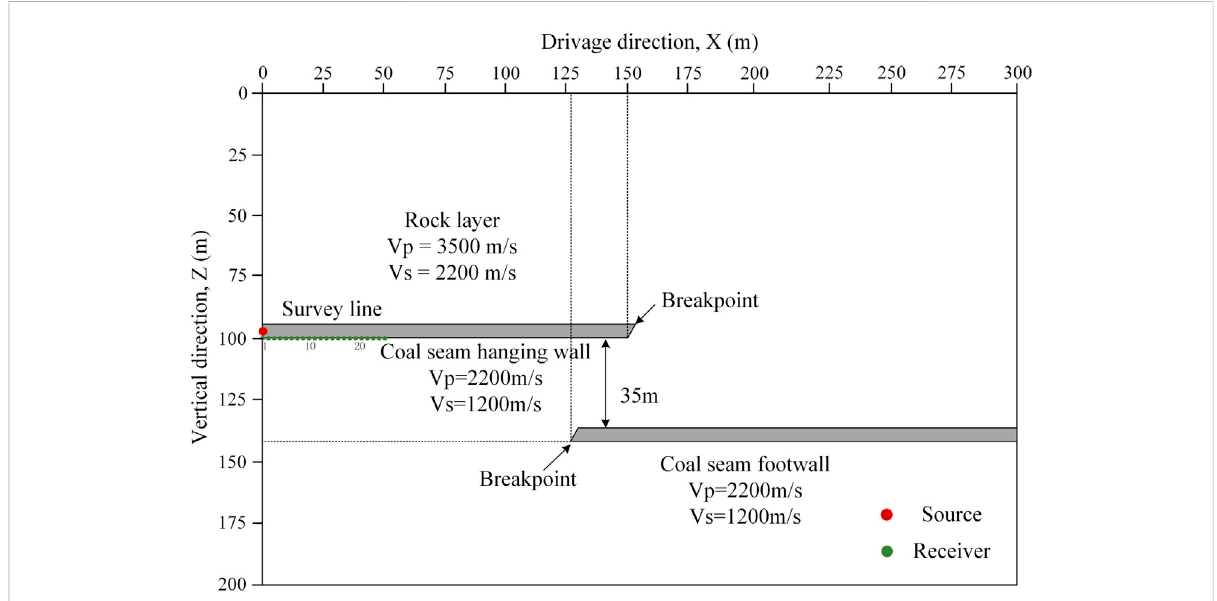
FIGURE 9 Model of the faulted coal seam.